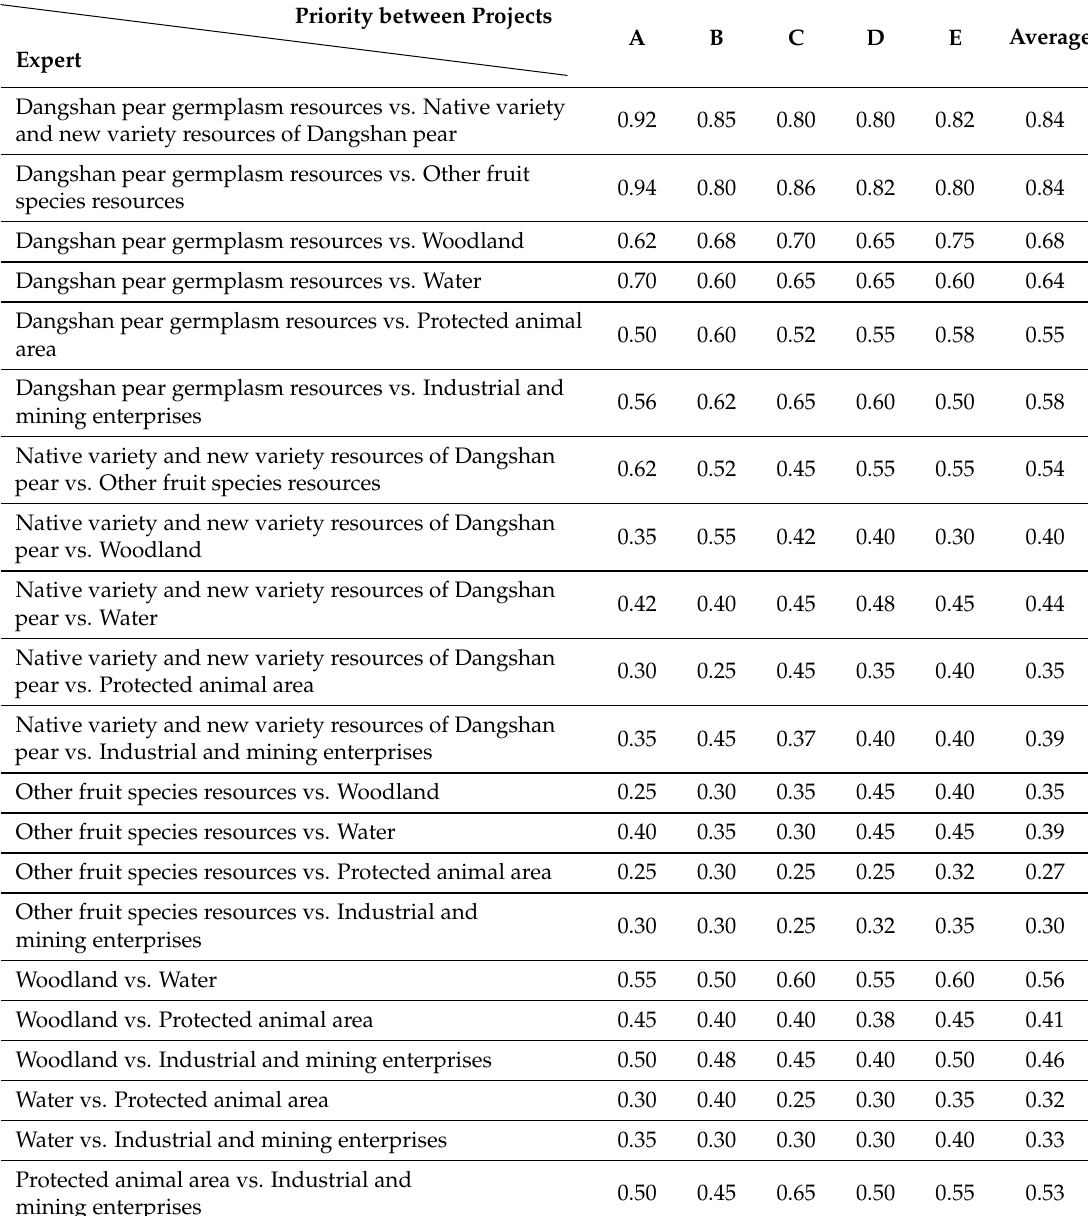
Table 2. Government regulatory role survey